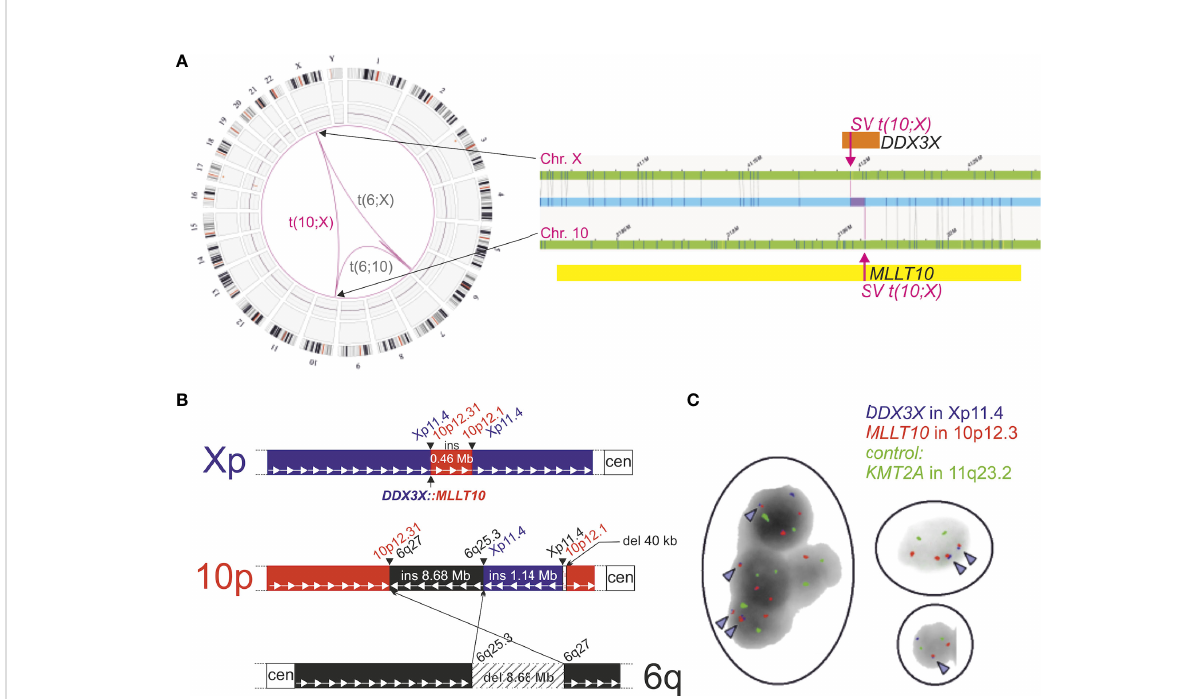
FIGURE 2 Detection of DDX3X: MLLT10 gene fusion by optical genome mapping at the fi rst time point and con fi rmation by FISH analysis. (A) Circos Plot (left) and detailed chromosome view SV visualization (right) of DDX3X: MLLT10 in Bionano Access v1.7 (Translocation Con fi dence: inter: 0.65, intra: 0.3) fi ltered for absence in controls. (B) Schematic overview of structural rearrangement. A 0.46-Mbp fragment of Chr. 10p including MLLT10 is transferred to Chr. Xp, fusing it to DDX3X . Furthermore, on Chr. 10p, an 8.68-Mbp fragment of Chr. 6q and a 1.14-Mbp fragment of Xp are inserted. Next to this insertion, a 40-kbp fragment is deleted. Both insertions are inverted and not in frame. (C) Interphase FISH analysis on bone marrow smear demonstrates DDX3X: MLLT10 gene fusion. Red signals (corresponding to MLLT10 at 10p12.13) and blue signals (corresponding to DDX3X at Xp11.4) are visualized adjacently and are indicated by arrowheads. In addition, green KMT2A control signals are not located in proximity to red MLLT10 hybridization signals, indicating the lack of involvement of KMT2A in the structural rearrangement. Analyzed cell nuclei reveal heterogeneous hybridization signals due to subclonal